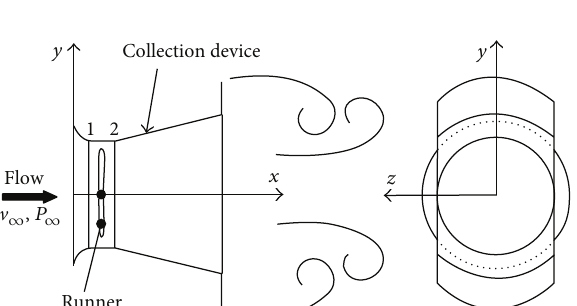
Figure 1: Hydraulic turbine.